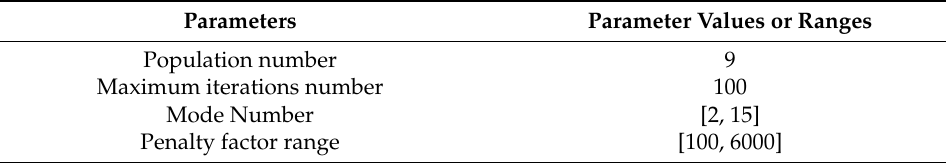
Table 10. Parameter configuration of GWO.